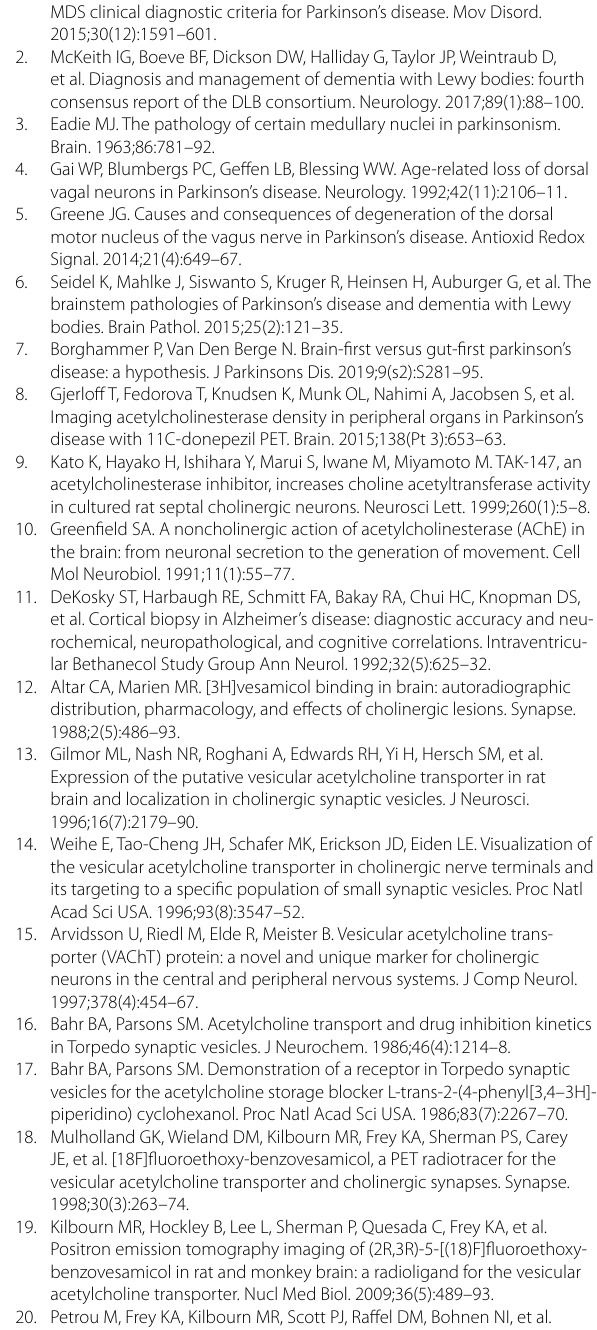
Additional file 6. Table S2: Best-fit-models in different organs. Compari- son of 1-tissue-, 2-tissue- and irreversible 2-tissue compartment